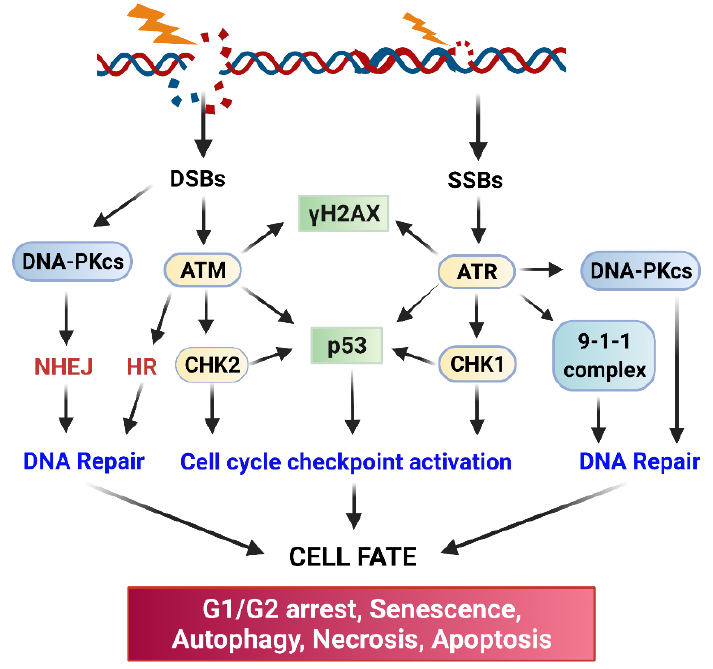
Figure 2. Core factors in DNA damage response and DNA repair networks. Ionizing radiation causes DNA damage that activates ATM, ATR, and DNA-PK kinases, which transmit signals to their downstream targets to promote DNA repair by NHEJ and HR while activating checkpoint response pathways to arrest the cell cycle. If the DNA damage cannot be repaired, other cellular signaling responses, such as those that lead to apoptosis, autophagy, and senescence induction will be triggered.